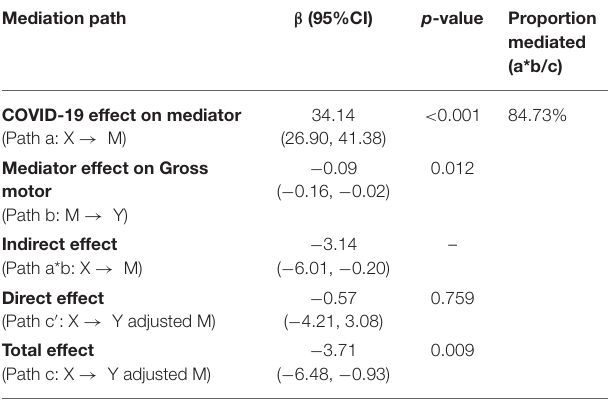
TABLE 3 | Mediation effect between SARS-CoV-2 infection and score of gross motor domain of ASQ-3. Mediation